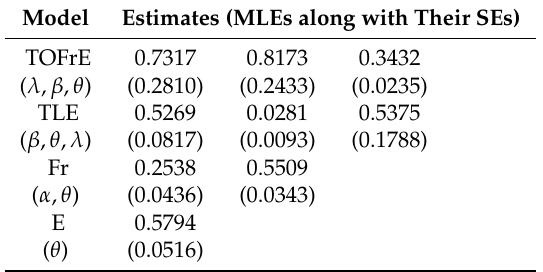
Table 8. Maximum likelihood estimates (MLEs) and standard errors (SEs) of the models for Data set I.